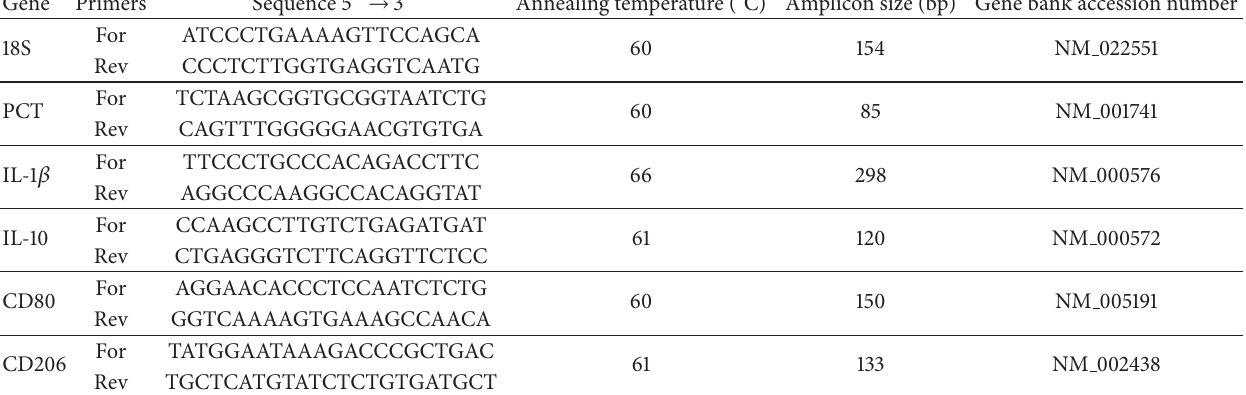
Table 1: Primer used for qPCR